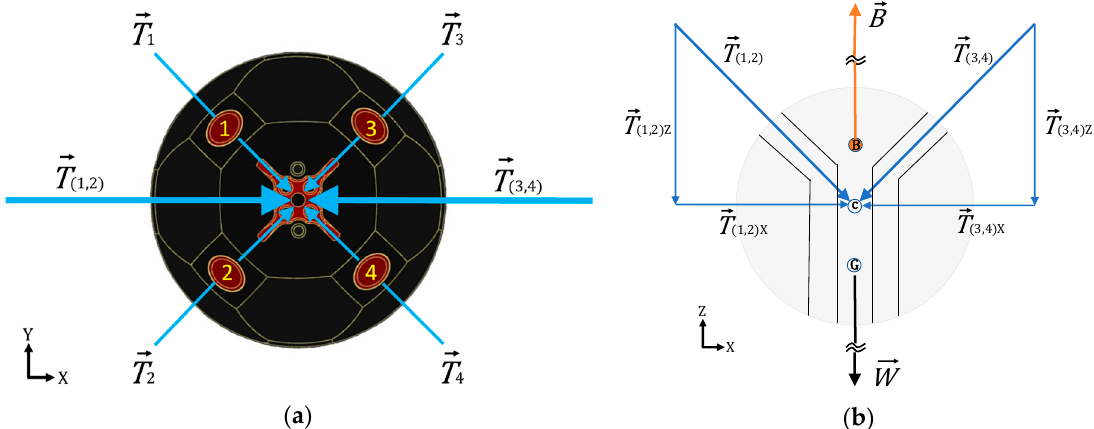
Figure 4. Thrust vector summation for WIEVLE’s four tunnel thrusters ( a ) Top view ( b ) Side view. Note the relative locations for B and G relative to C. These three key points are located along the central, vertical axis. The relative positions are depicted, but the precise distances and magnitudes of the vectors are unknown.